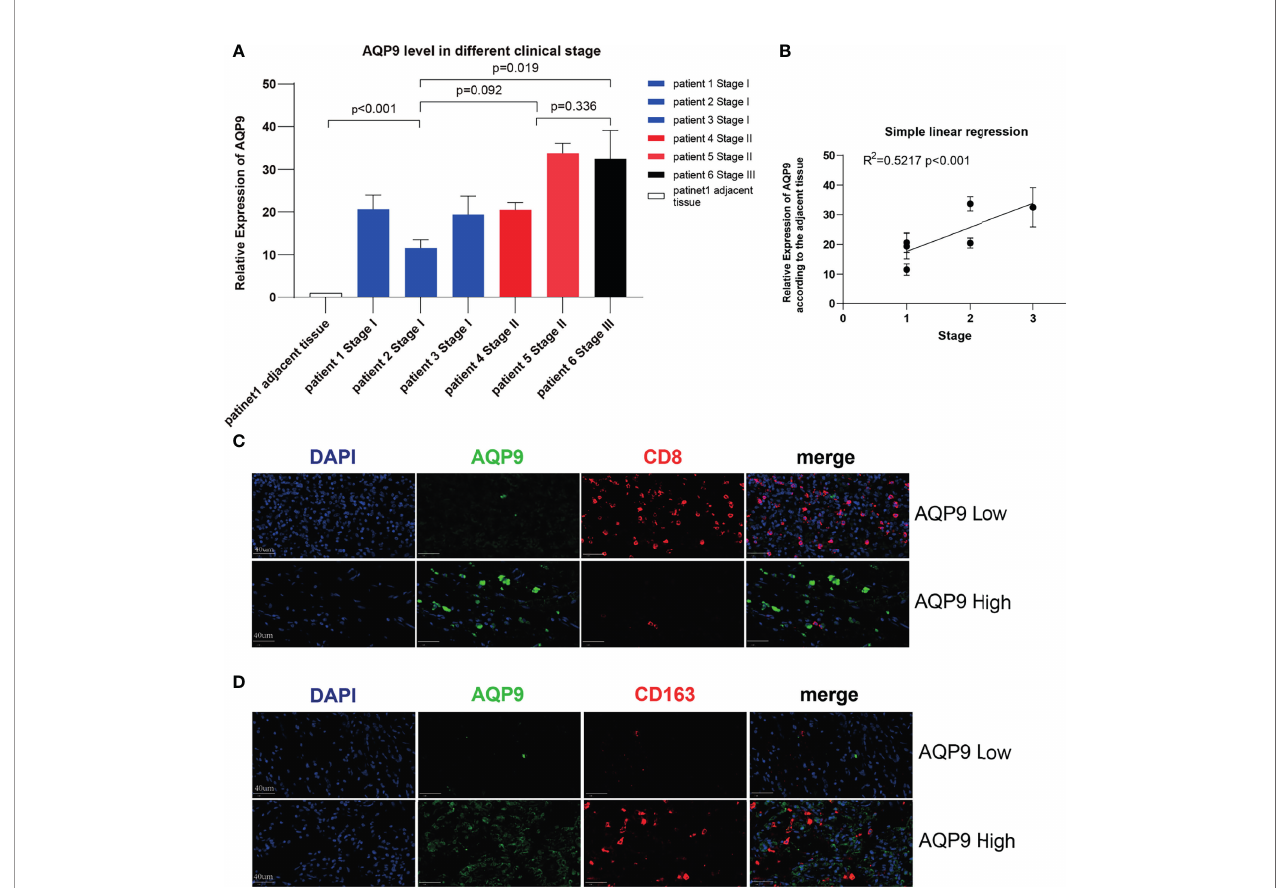
FIGURE 7 | Validation in kidney renal clear cell carcinoma (KIRC) patients. (A) The real-time quantitative PCR (RT-qPCR) result of aquaporin 9 (AQP9) in patients of different KIRC stages. (B) Simple linear regression of AQP9 level according to the different stages. (C, D) Multiple immunohistochemistry (mIHC) result of AQP9, CD163, and CD8 in KIRC tumor